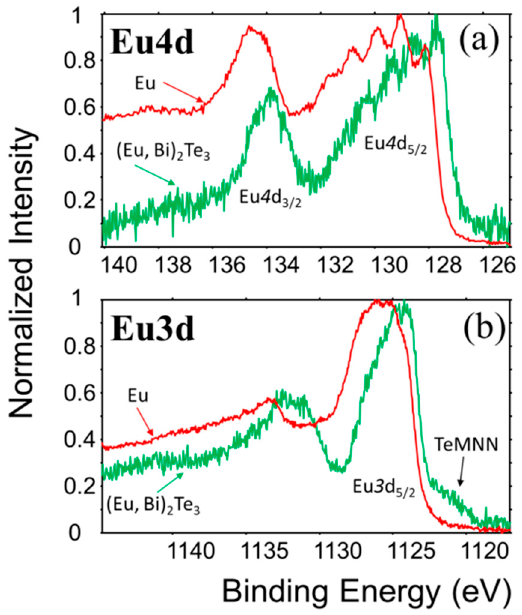
Figure 5. XPS spectra of Eu 3d ( a ) and Eu 4d ( b ) multiplets for pure europium and europium in (Eu, Bi) 2 Te 3 film.